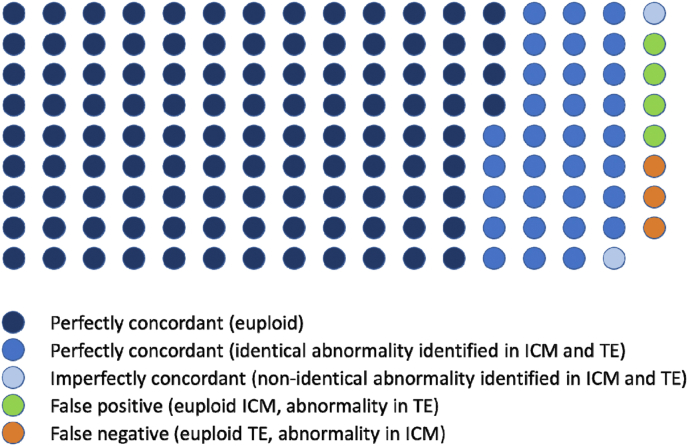
Depiction of the 152 OPU-IVP blastocysts analysed for chromosome abnormalities in both ICM and TE lineages. The perfect concordance of 112 euploid and 31 abnormal embryos indicates an incidence proportionately of 0.94. This increases to 145 (proportionately 0.95) for perfect and imperfect concordance combined. The 4 so called “false positives” should, most likely, not be transferred as they may lead to placental insufficiency, leaving only 3 (proportionately 0.02) in which a genuine misdiagnosis (false negative) was made.